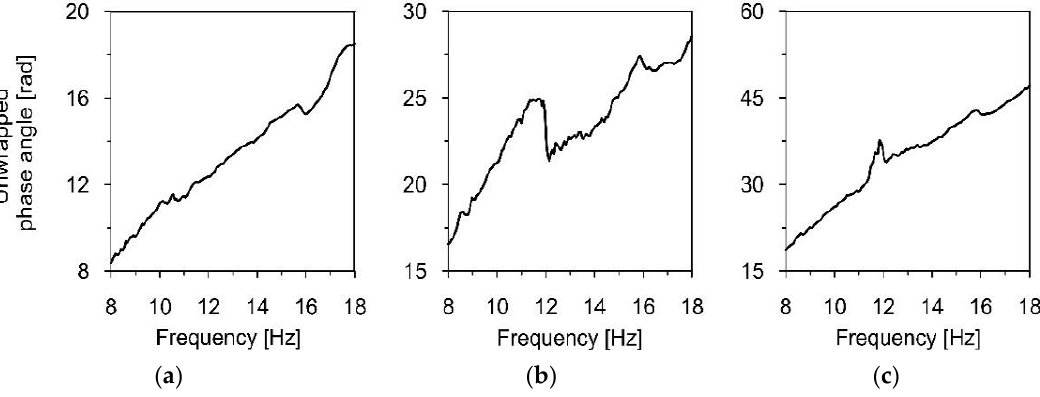
Figure 13. The function of phase angle in unwrapped form for pairs: ( a ) P1 – P2, ( b ) P1 – P3, ( c ) P2 – P3. Based on the phase angle function, the time delay of the wave was determined for the support pairs (see Equation (19)) and the selected frequencies. As previously men- tioned, the mean wave velocities between the particular piers (averaged over five series) and the mean apparent wave velocities between support pairs (averaged over different frequencies) are presented (Table 5). Table 5. The mean value of the wave velocity between supports determined by the unwrapped phase angle function.